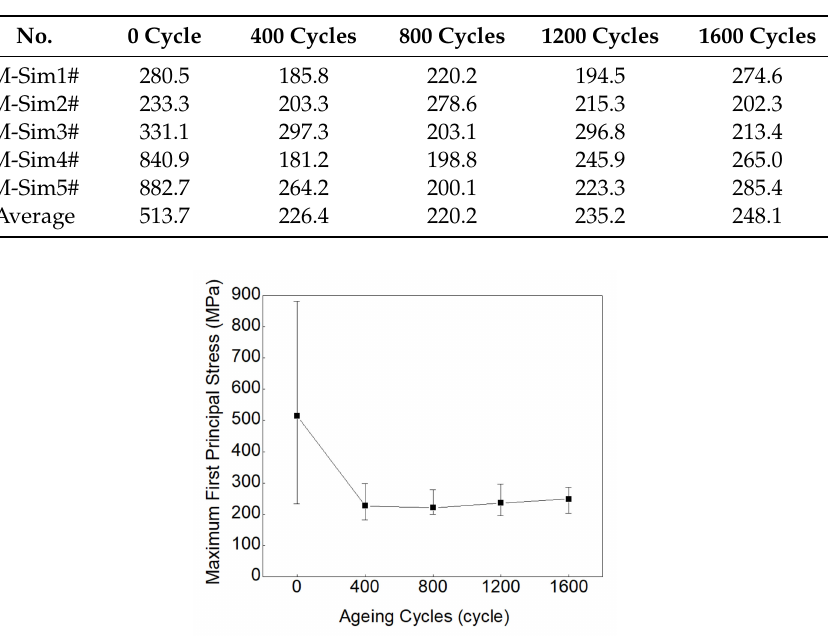
Figure 6. The simulated first principal stress of solder joints vs. ageing cycles.